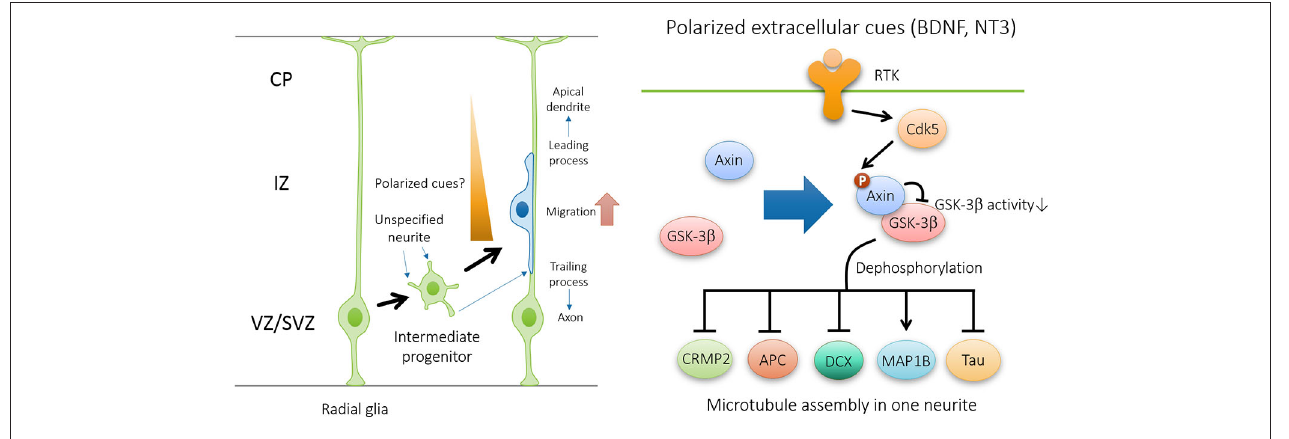
interaction and local inhibition of GSK3 β activity at the tip of nascent axon, and thus promotes microtubule assembly through the regulation of various microtubule-associated proteins, including CRMP2, APC, DCX, MAP1B, and